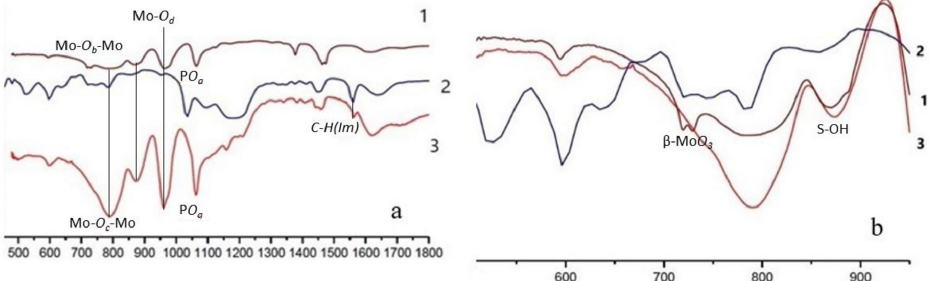
Figure 2. IR spectra (1)—H 3 PMo 12 O 40 ; (2)—4-(3 (cid:48) -ethylimidazolium)-butanesulfonate; (3) PMoIL1 in